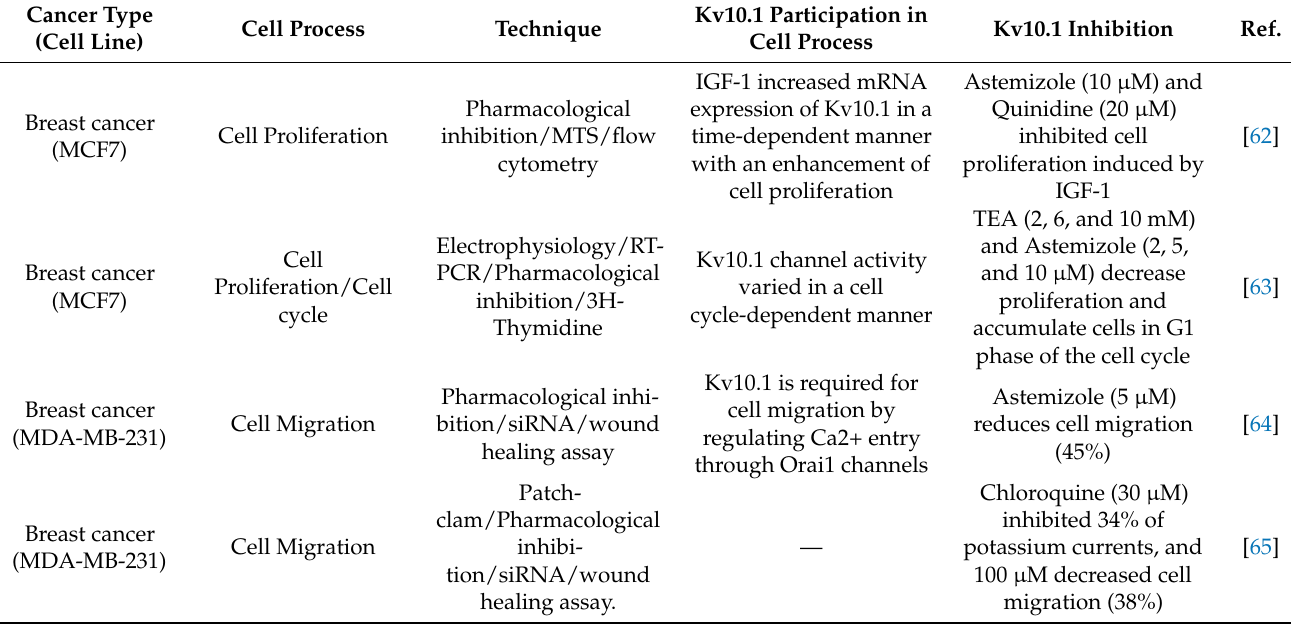
Table 2. Kv10.1 effects on cancer cell lines and/or its pharmacological